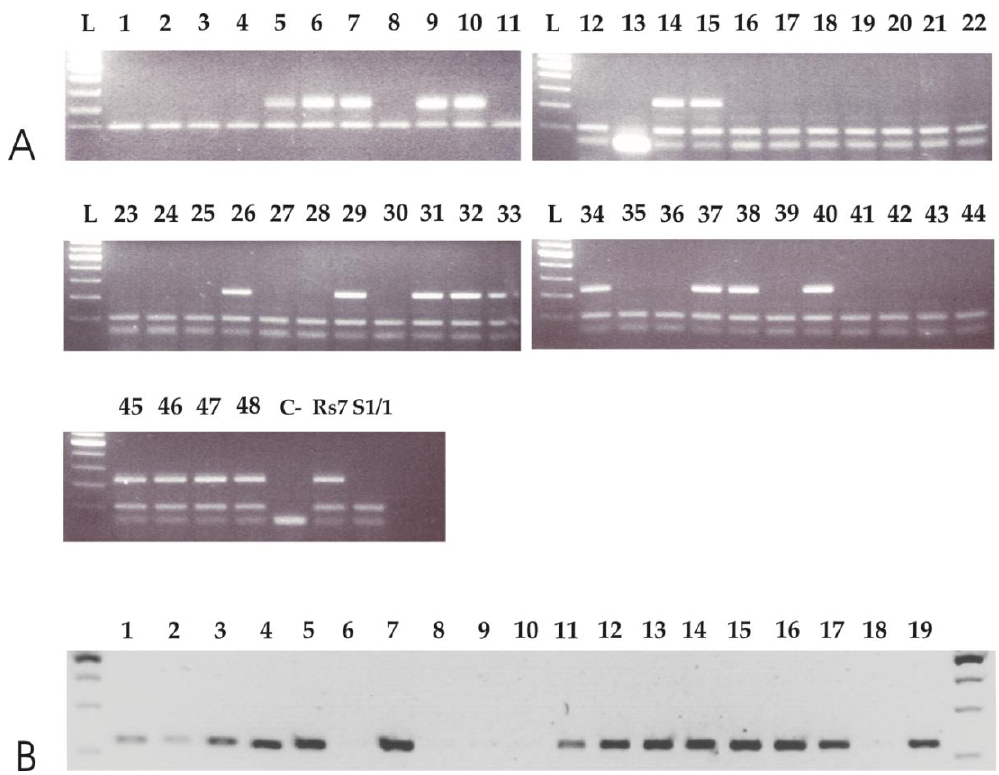
Figure 3. ( A ) APO-SCAR primer pair tested on 48 F1 individuals (lanes 1–48) from a segregating population for the mode of reproduction and obtained by crossing an apomictic (RS7, lane 50) and a sexual (S1/1, lane 51) genotype, as reported in Albertini et al. 2001 [12]. APO-SCAR completely co-segregate with apomixis; ( B ) on exotic germplasm sources of known reproductive behavior (Table